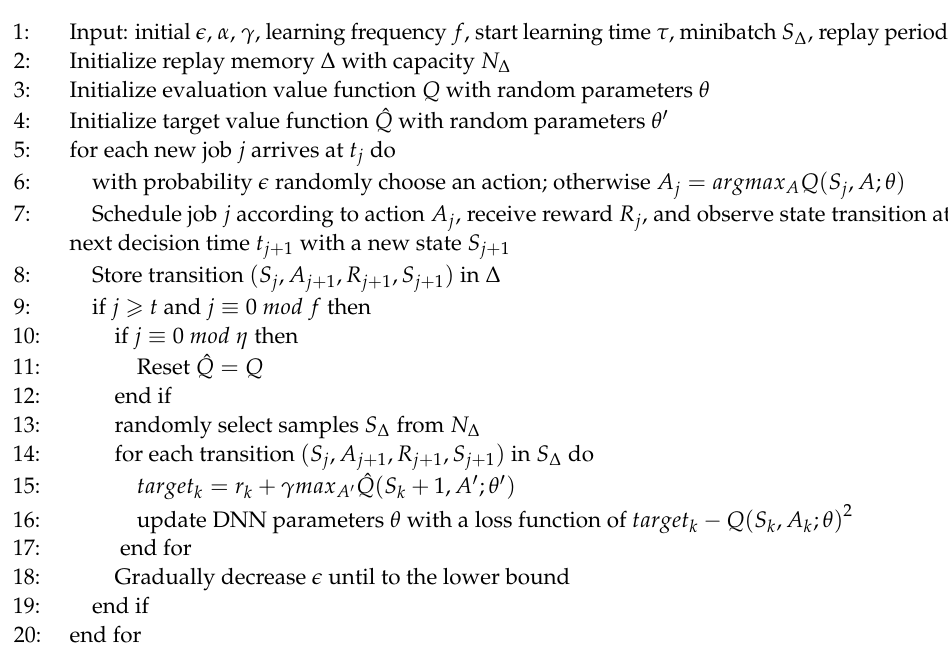
Algorithm 1: The DRL-based algorithm for real-time cost optimization of the